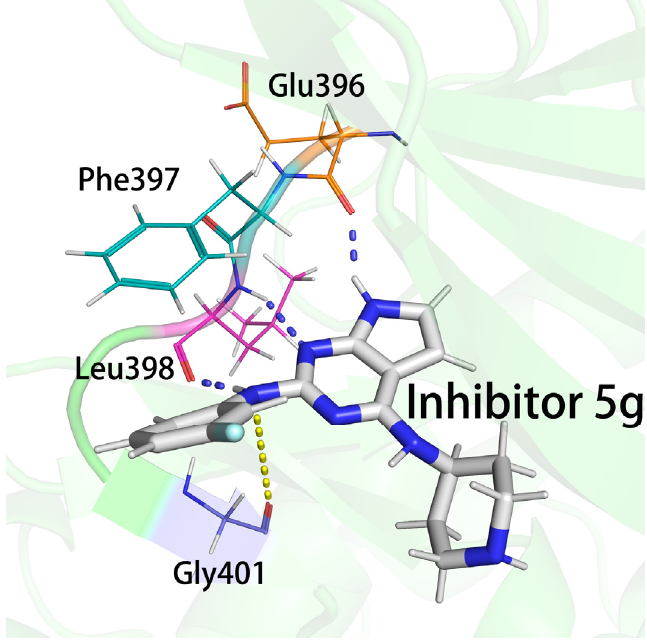
Figure 8. The locations and interactions of hinge region residues with inhibitors. The formation of triple hydrogen bonds between Glu396 and Leu398 and the inhibitor is indicated by the blue dashed line, and the electrostatic interaction of the oxygen atom on the Gly401 backbone with the 2-imino group is indicated by the yellow dashed line.